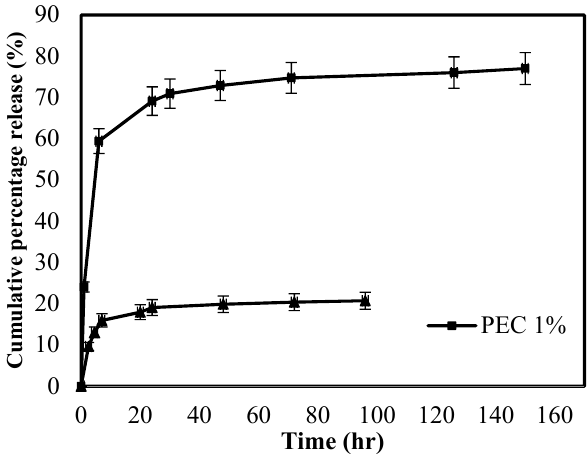
Figure 9. Drug releases of TM-PEC films.